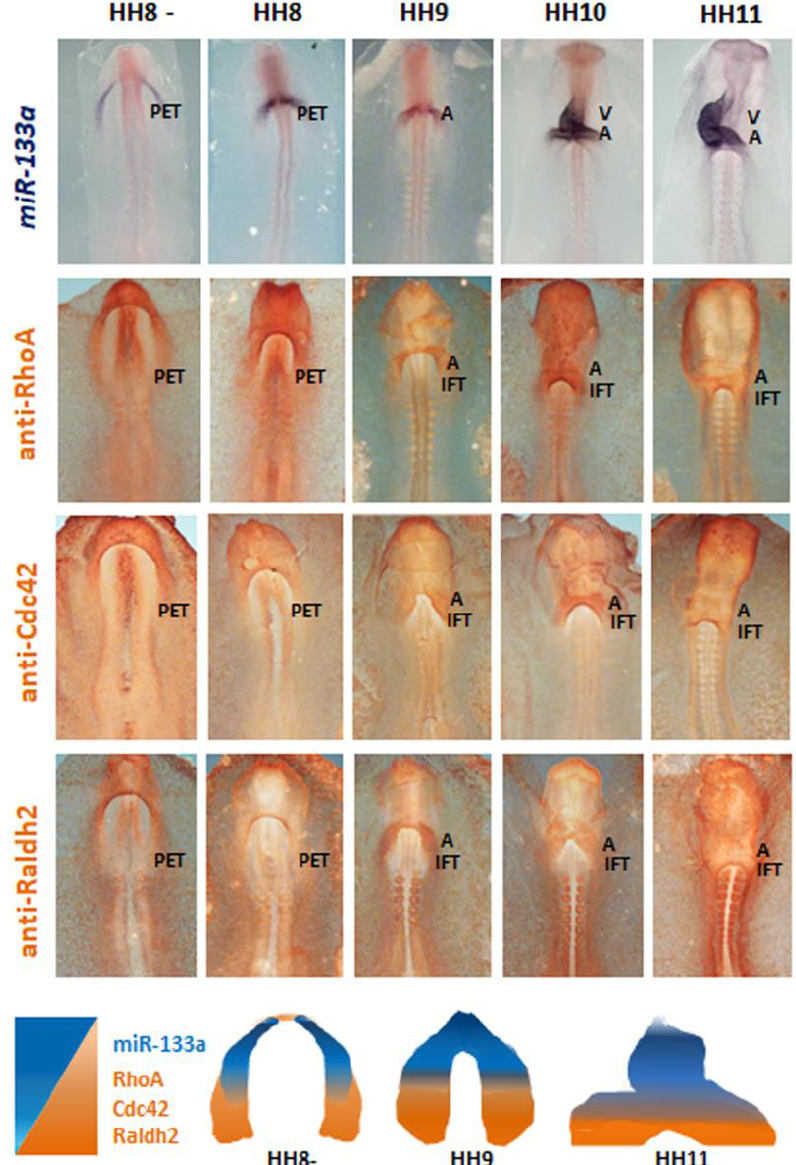
Figure 2. Whole-mount ISH for miR-133a and whole mount IMH for RhoA, Cdc42 and Raldh2 during early chick cardiac development, from HH8 – HH11 stages, in control embryos. Note miR-133a expression pattern at the level of the anterior region of the primitive endocardial tube (PET), being observable in the atrium (A) and ventricle (V) at later stages. Note the location of RhoA, Cdc42 and Raldh2 at the level of the PET posterior region, and subsequently in the atrium and inflow tract (IFT). The scheme illustrates the complementary location in cranial-caudal trend of miR-133a (blue) in comparison with RhoA, Cdc42 and Raldh2 (orange).